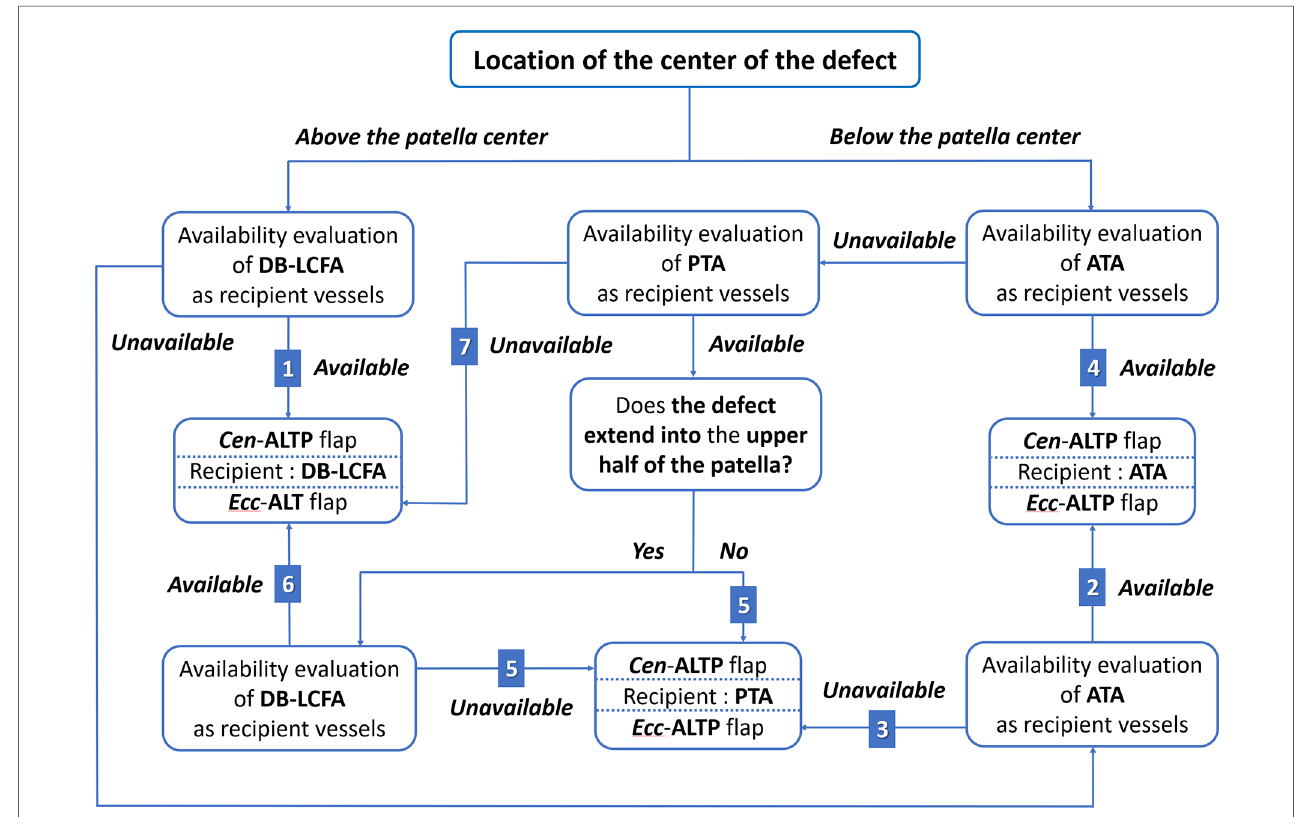
FIGURE 4 An algorithmic approach to selecting the optimal ALTP fl ap-type and most appropriate recipient vessels for the soft-tissue reconstruction of the knee area in patients with chronic post-traumatic osteomyelitis. The available options on the combination of the fl ap-type and the recipient vessels were given a number from 1 to 7. (DB-LCFA, descending branch of the lateral circum fl ex femoral artery; PTA, posterior tibial artery; ATA, anterior tibial artery; ALTP, anterolateral thigh perforator; Cen-ALTP fl ap, ALTP fl ap with centrally located perforators; Ecc-ALTP, ALTP fl ap with eccentrically located